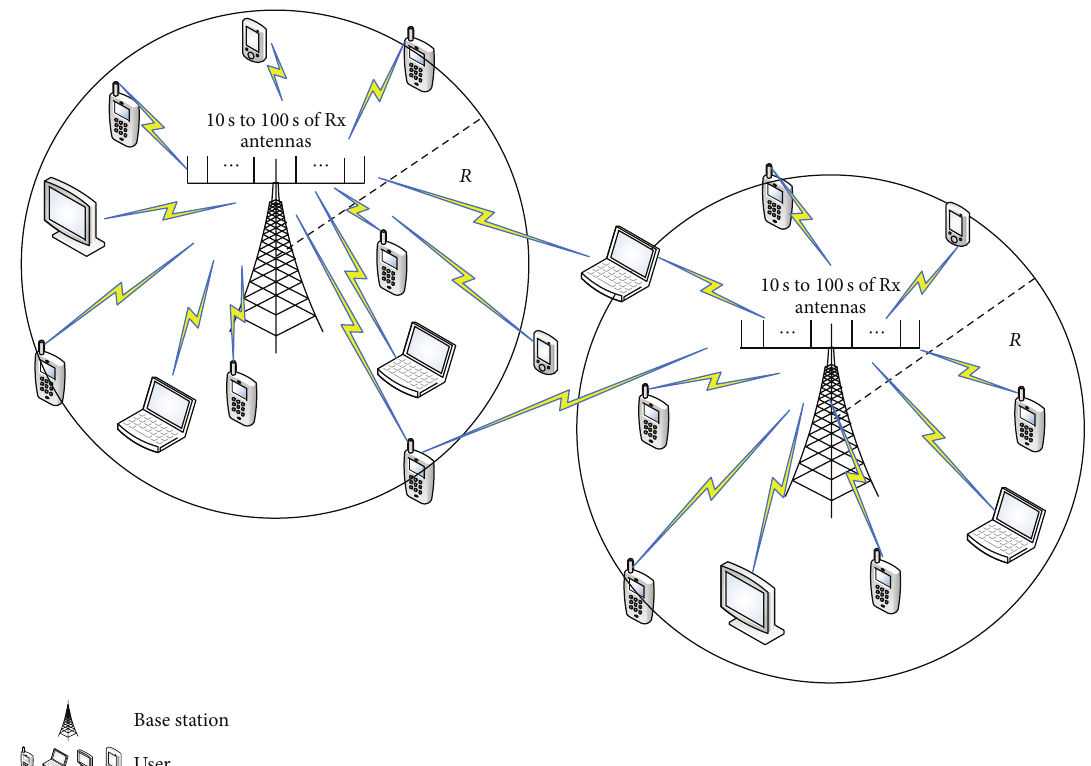
Figure 1: Large-scale multiuser MIMO communication system